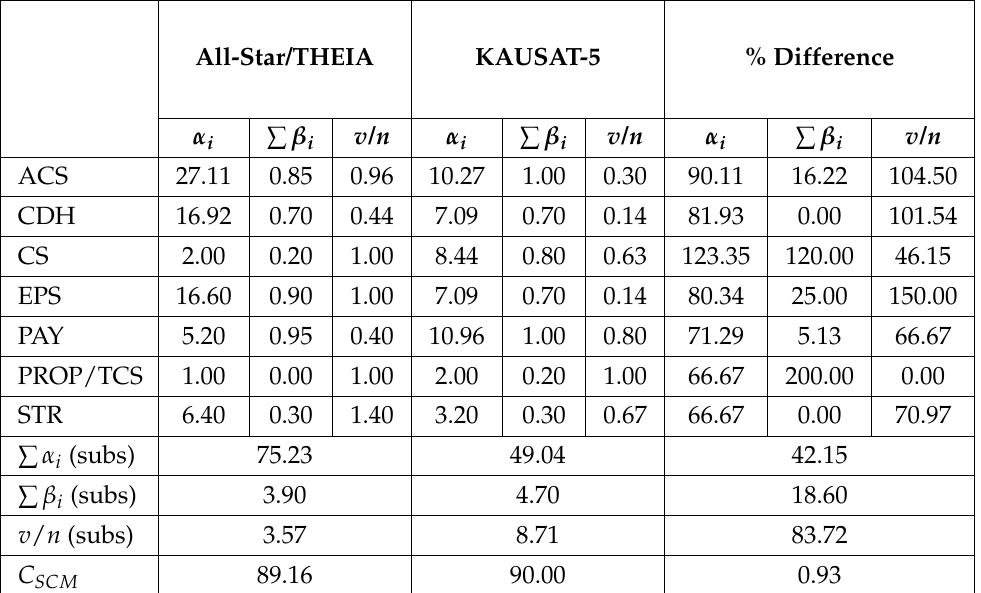
Table 4. Results of CubeSat